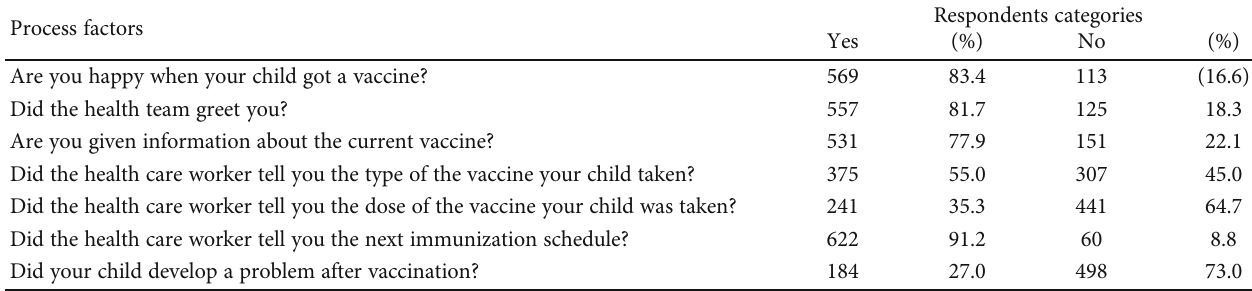
Table 3: Process-related factors for mothers in Wadla district, North Wollo, Amhara regional state, northeast Ethiopia, 2019 ( n = 682 ). Process factors